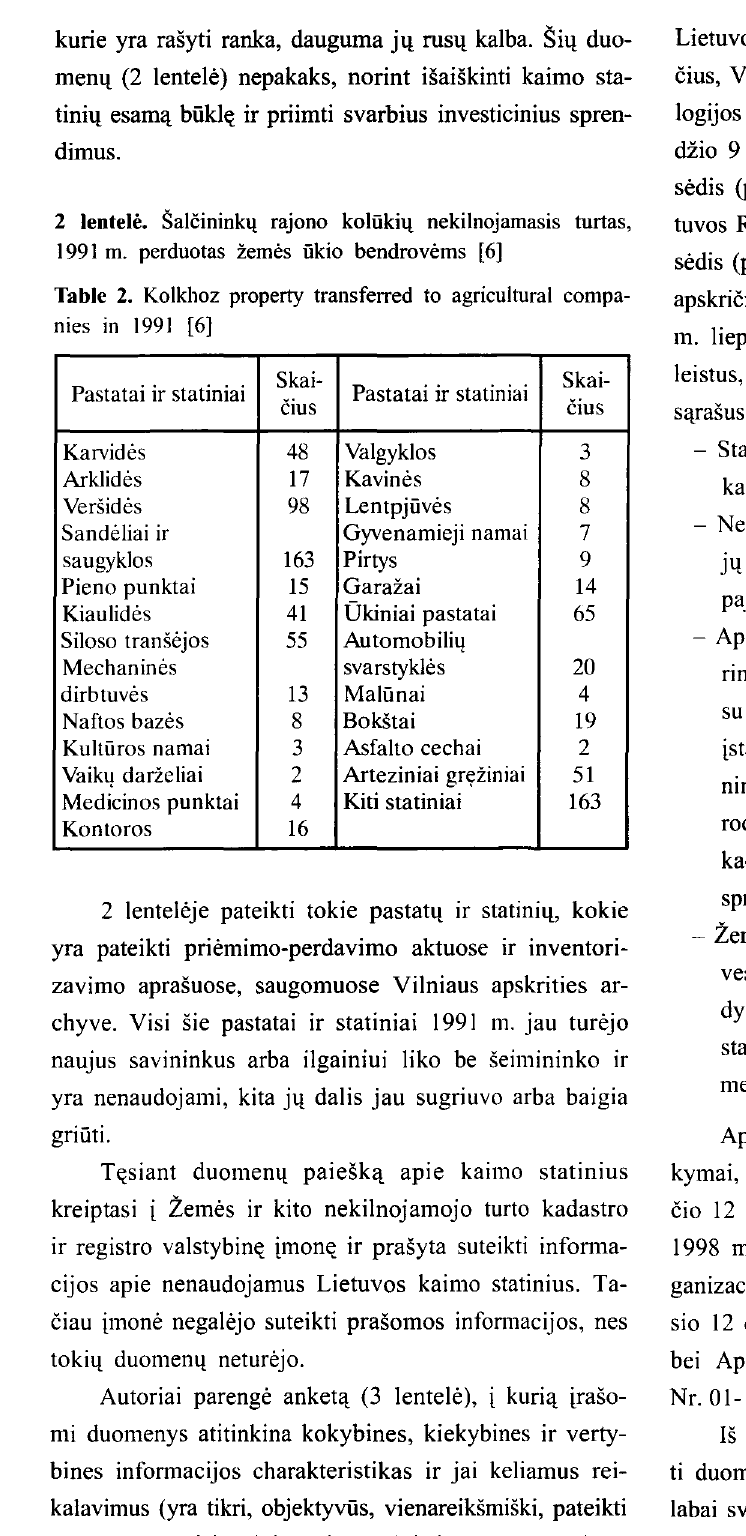
Table 2. Kolkhoz property transferred to agricultural compa nies in 1991